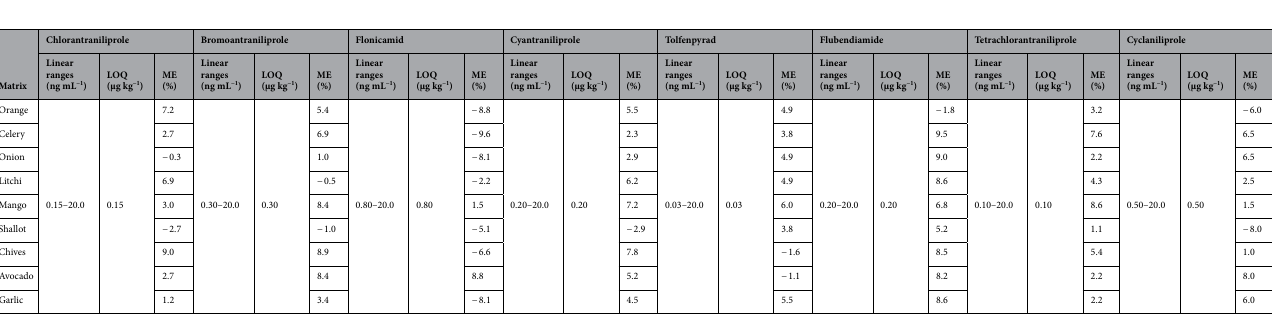
Table 2. Linear ranges, limits of quantitation (LOQs) and matrix effect of amide pesticides in different